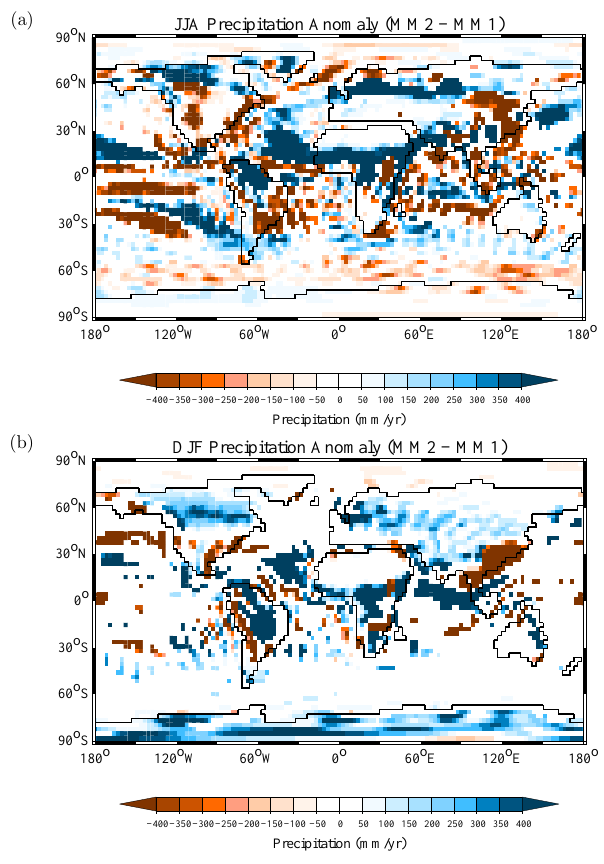
Fig. 9. Precipitation anomalies in (a) Northern Hemisphere sum- mer (JJA) and (b) Northern Hemisphere winter (DJF) between ex- periments MM2 and MM1.